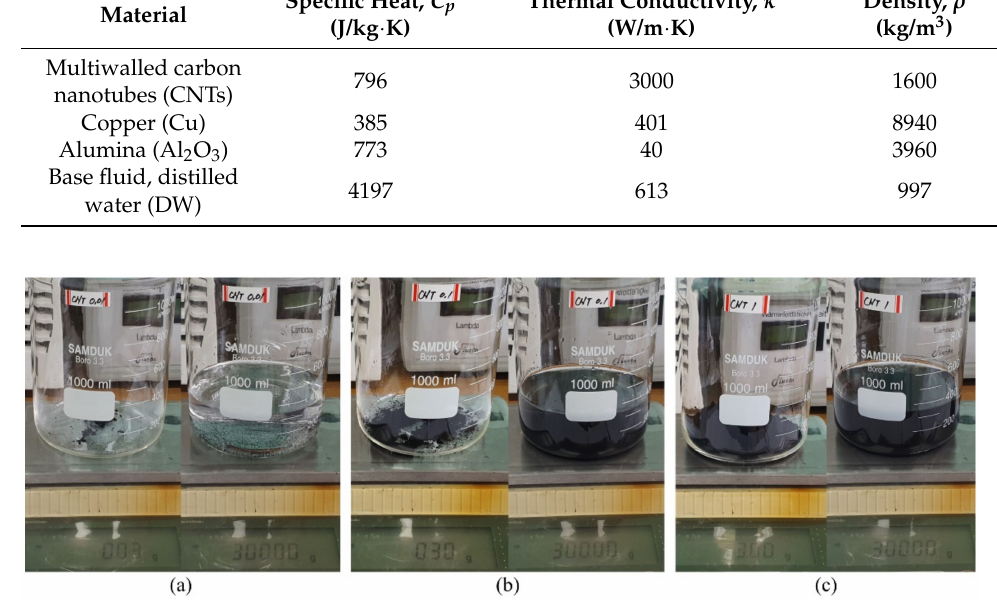
Figure 1. CNTs nanofluid of varying concentrations. ( a ) 0.01 wt.%, ( b ) 0.1 wt.%, and ( c ) 1